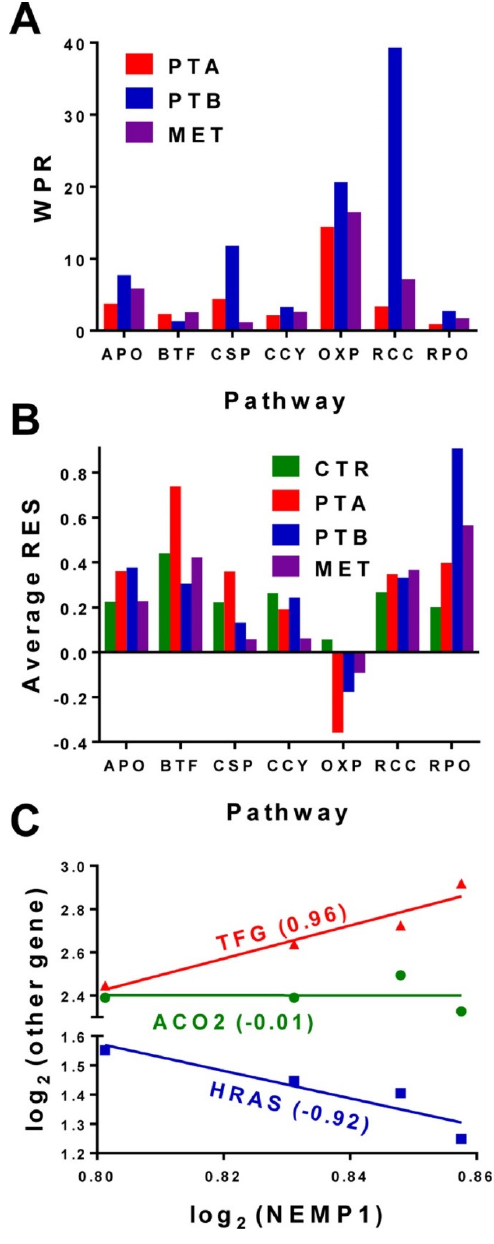
Figure 2. Expression data from [21]: ( A ). Average Relative Expression Stability (RES) of several functional pathways in the four regions profiled from the clear cell renal cell (CCRCC) samples. Note that the RNA polymerase (RPO) and basal transcription factors (BTF) are the most protected pathways, while the control of the oxidative phosphorylation (OXP) is relaxed, presumably to allow the cells to adapt the environmental conditions. ( B ). Weighted Pathway Regulation (WPR) analysis of several functional pathways. Pathways: APO = apoptosis, BTF = basal transcription factors, CCY = cell cycle, CSP = chemokine signaling, OXP = oxidative phosphorylation, RCC = renal cell carcinoma, RPO = RNA polymerase. ( C ). Example of the correlation analysis in BCPAP cells (expression data from [22]). NEMP1 is synergistically expressed with TFG (trafficking from ER to golgi regulator), antagonistically expressed with HRAS (Harvey rat sarcoma viral oncogene homolog) and independently expressed with ACO2 (aconitase 2, mitochondrial) in BCPAP cells.